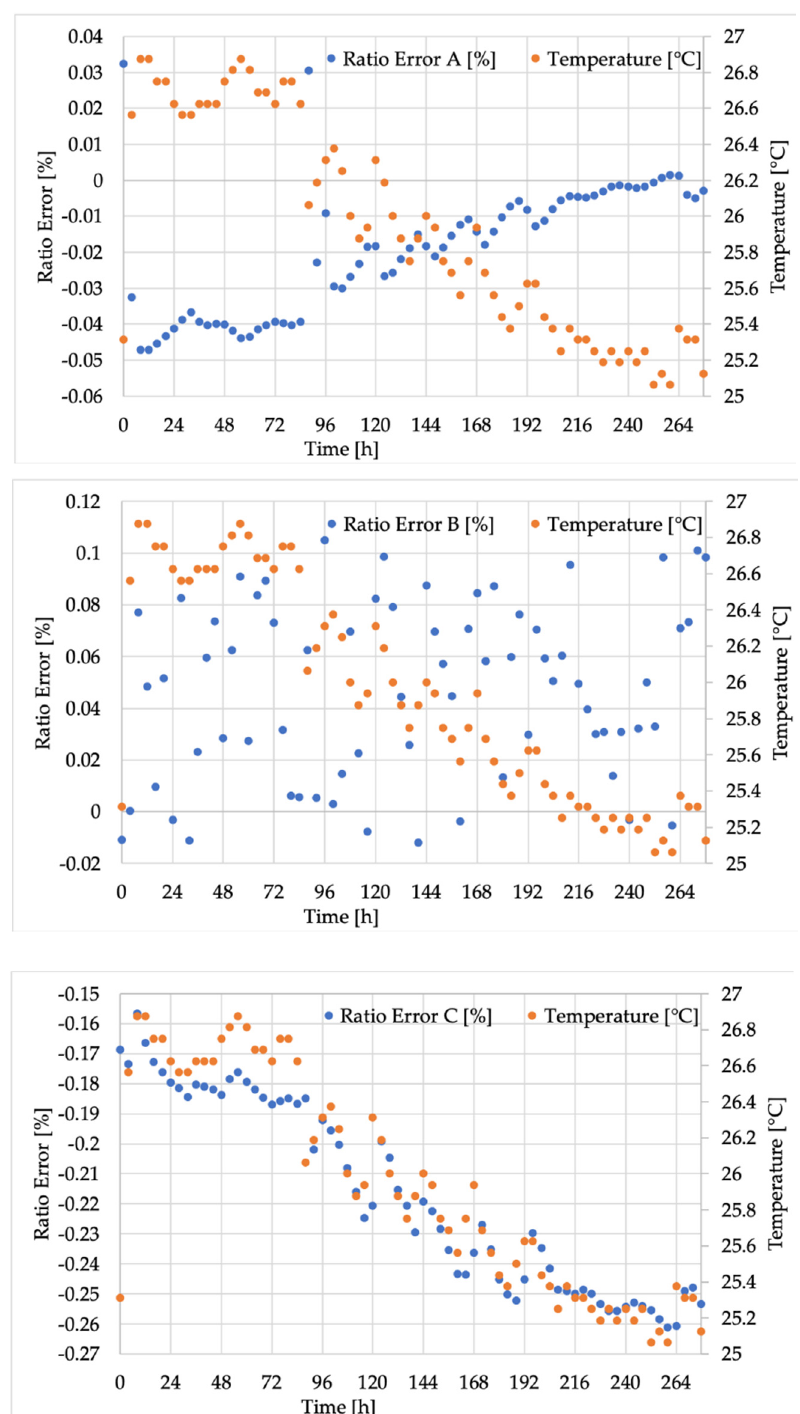
Figure 4. Ratio error results for VTs ( A – C ) (from top to bottom).